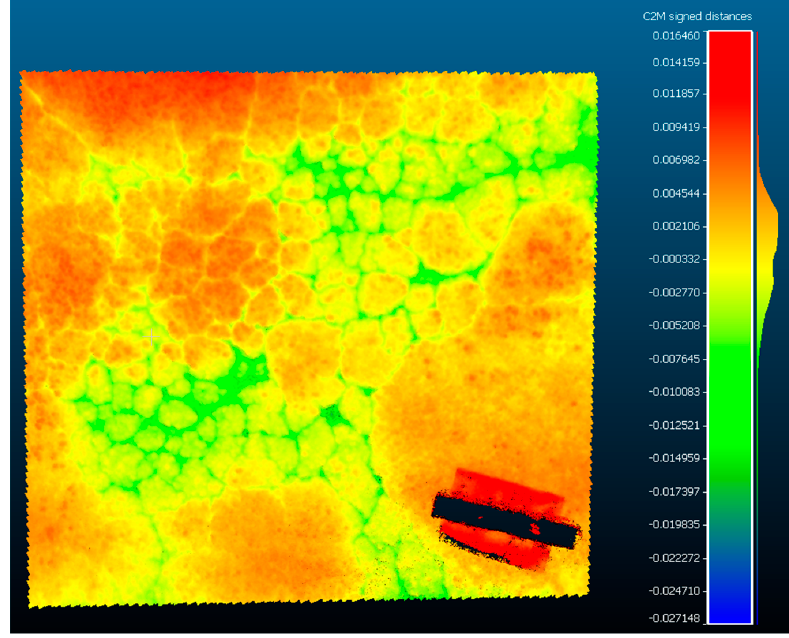
Figure 24. Pavement section 3 with the depth map created.